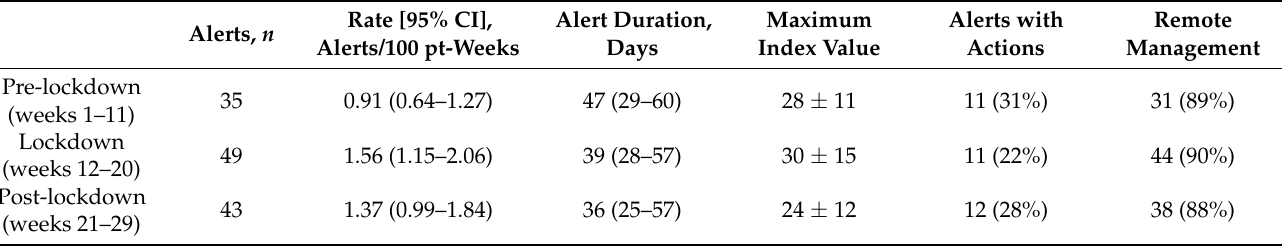
Table 2. HeartLogic alerts during the study